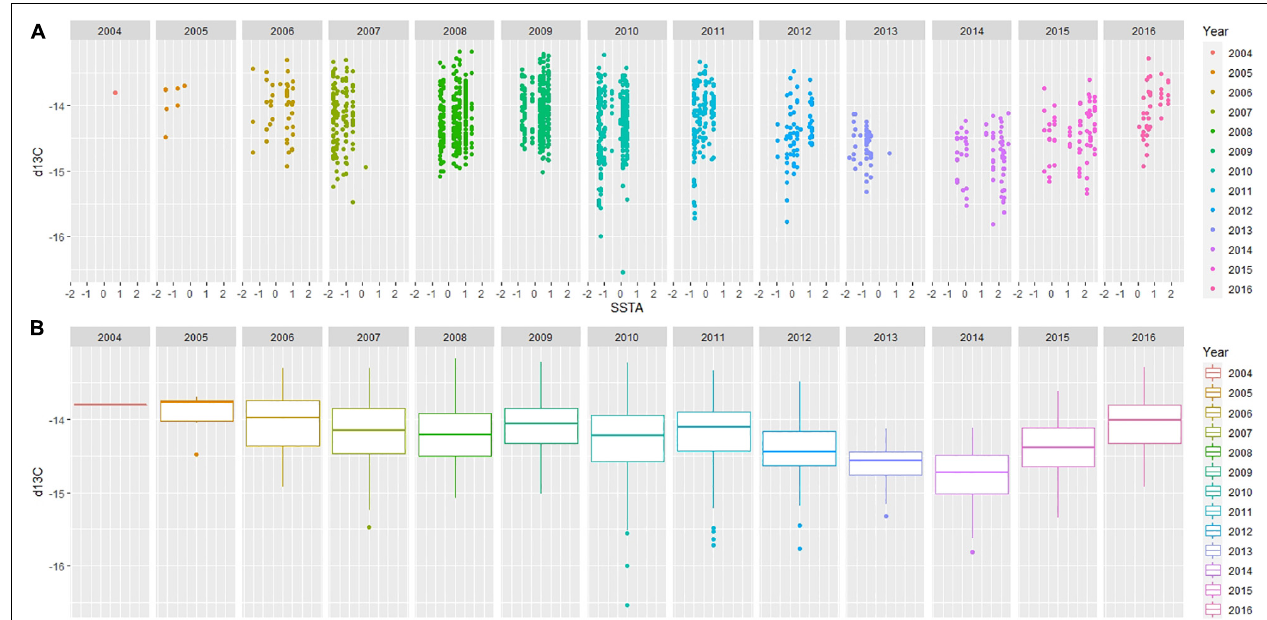
FIGURE 3 | (A) Mixed Linear Effects ggplot of Model 1. δ 13 C measured in parts per thousand (